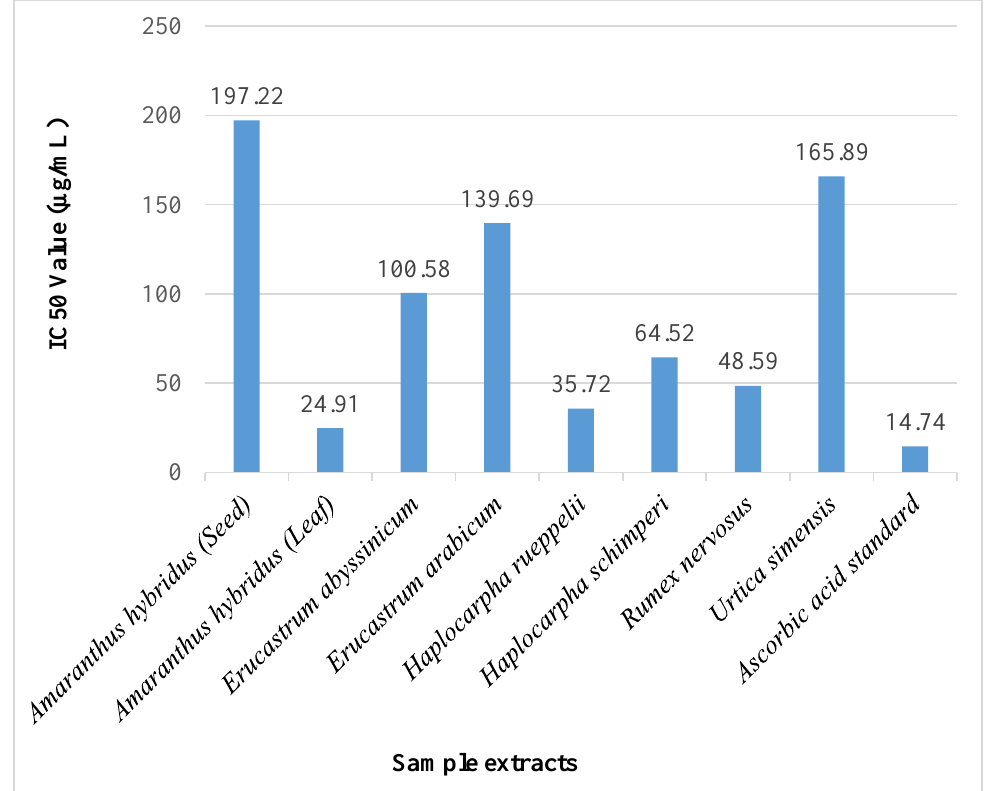
Figure 2. IC50 values in DPPH radical scavenging activity of WEPs.